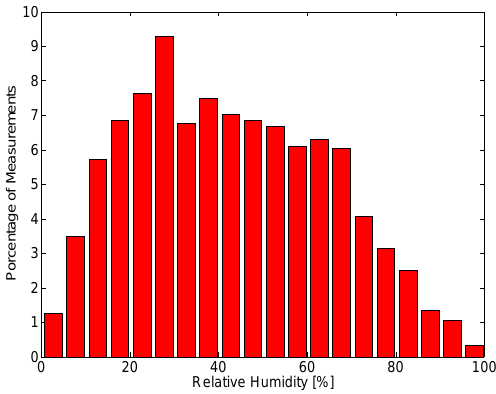
Fig. 8. RH distribution obtained from 500m layers for 1 year of